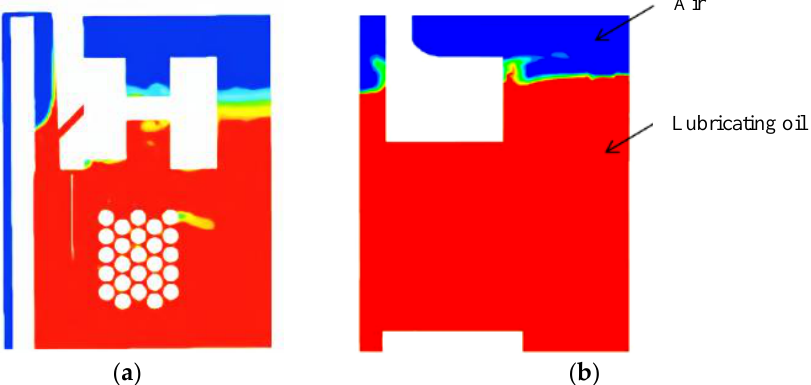
Figure 9. Gas – liquid interface of the overall and 1/12 model. ( a ) The gas – liquid interface of the over- all model [116]; ( b ) gas – liquid interface of the 1/12 model [41]. model [116]; ( b ) gas-liquid interface of the 1/12 model